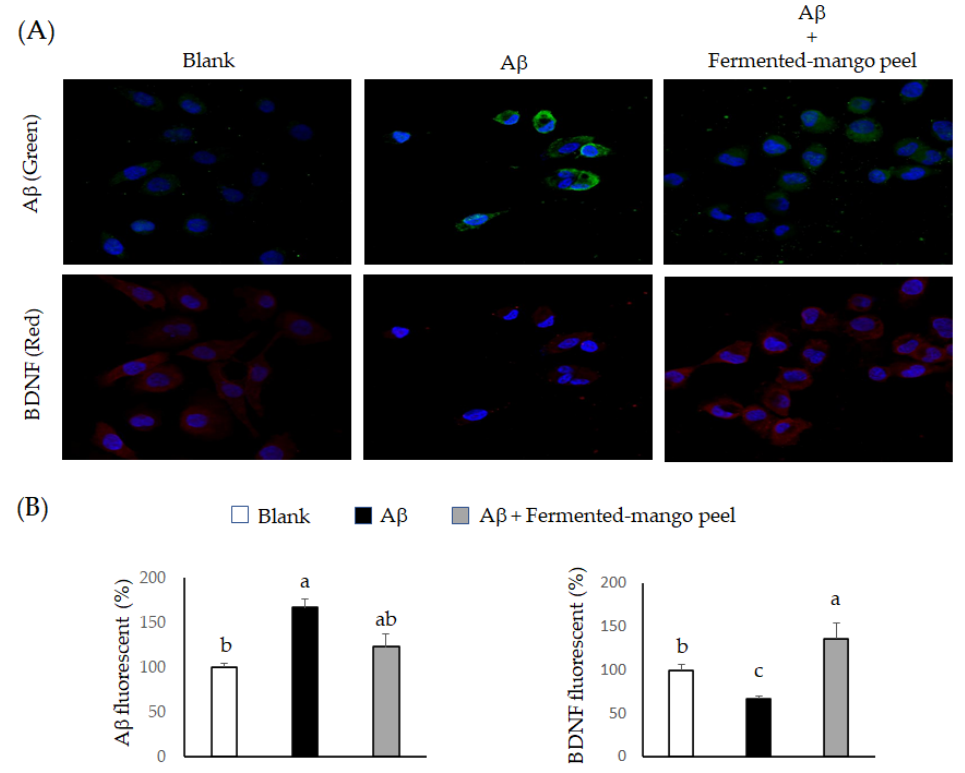
Figure 8. The regulations of L. acidophilus (BCRC14079)-fermented mango peel extracts on A β accumulation (green stain) and BDNF expression (red stain) in Neuron-2A cells treated with A β for 36 h. ( A ) ICC stain. ( B ) Quantitative results of fluorescence staining. Data are shown as means ± SD ( n = 3). Significant differences are shown by various letters ( p < 0.05).